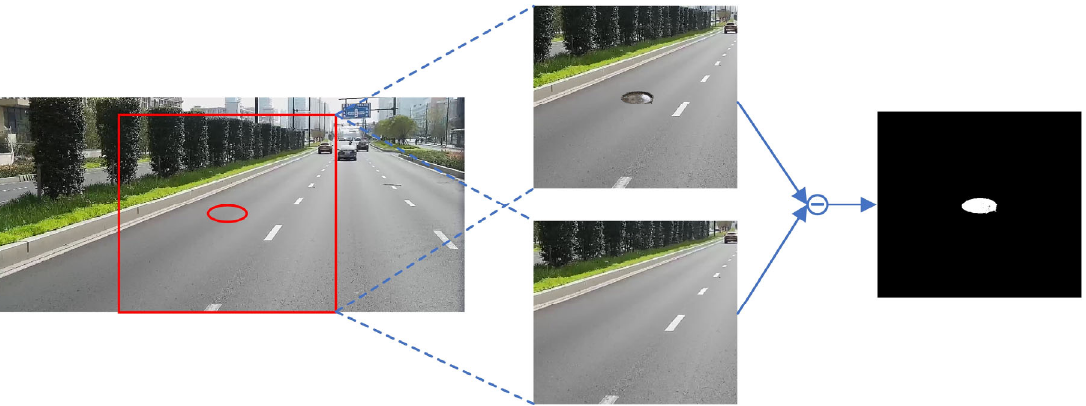
Figure 8. Example of image block capture and mask generation. The red ellipse represents the pasting position of the manhole cover.